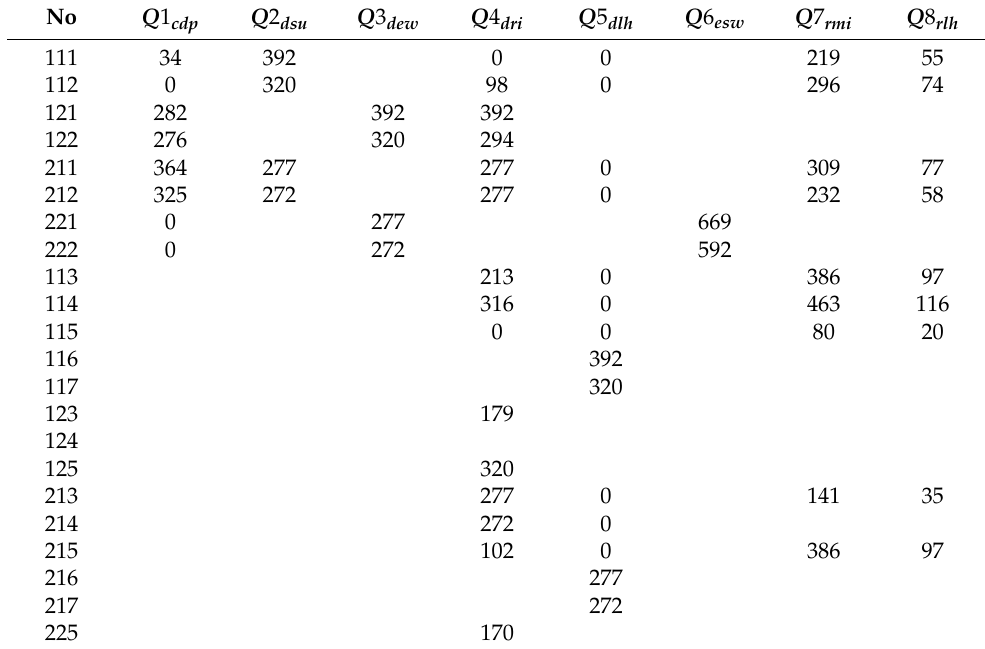
Table 17. The flow of materials and components within the network at α = 0.7 (3rd